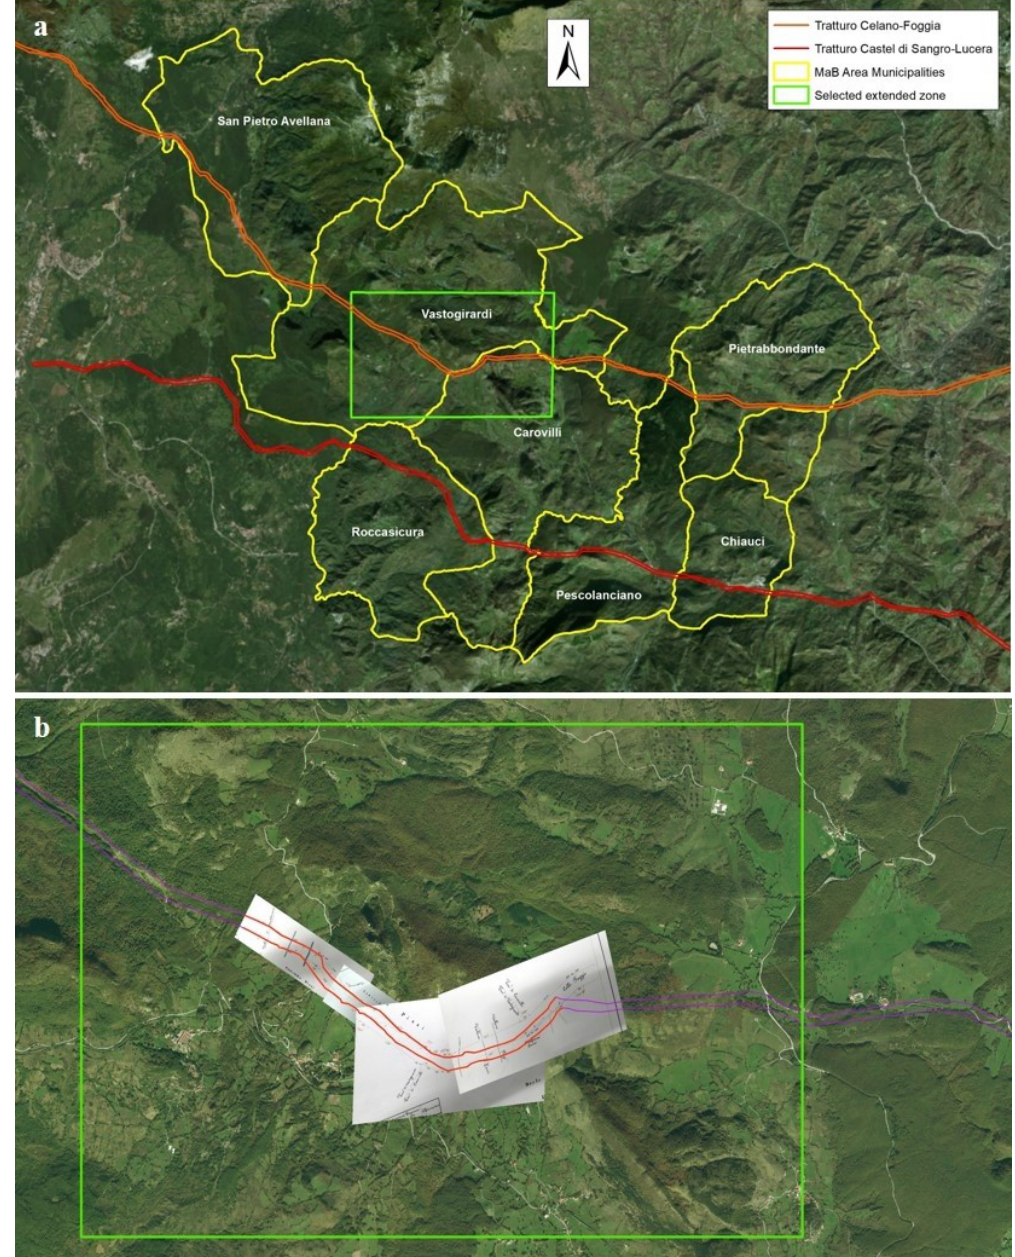
Figure 7. The pilot area in the territories of Vastogirardi and Carovilli: ( a ) Selection of the extended zone (green) in the MaB area; ( b ) The historic maps georeferenced related to the selected stretch of the Celano‑Foggia drove road.